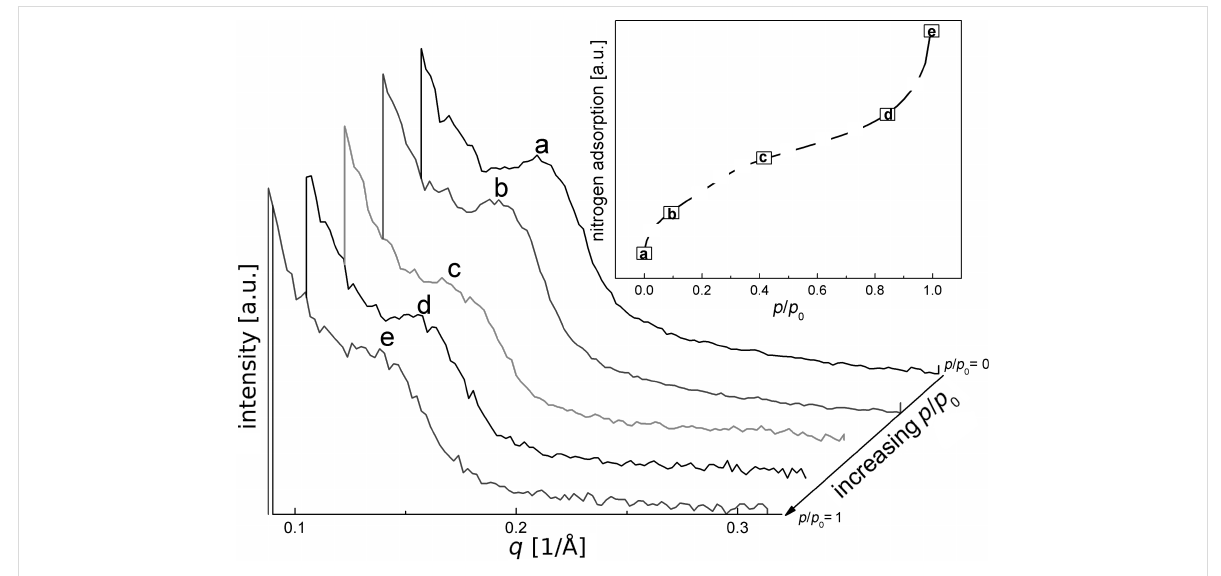
Figure 5: Neutron diffraction patterns of functionalized benzene-PMO-(1.65 mmol SO 3 H·g − 1 ) grafted on benzene rings and on silanol groups at small q values at different stages of nitrogen